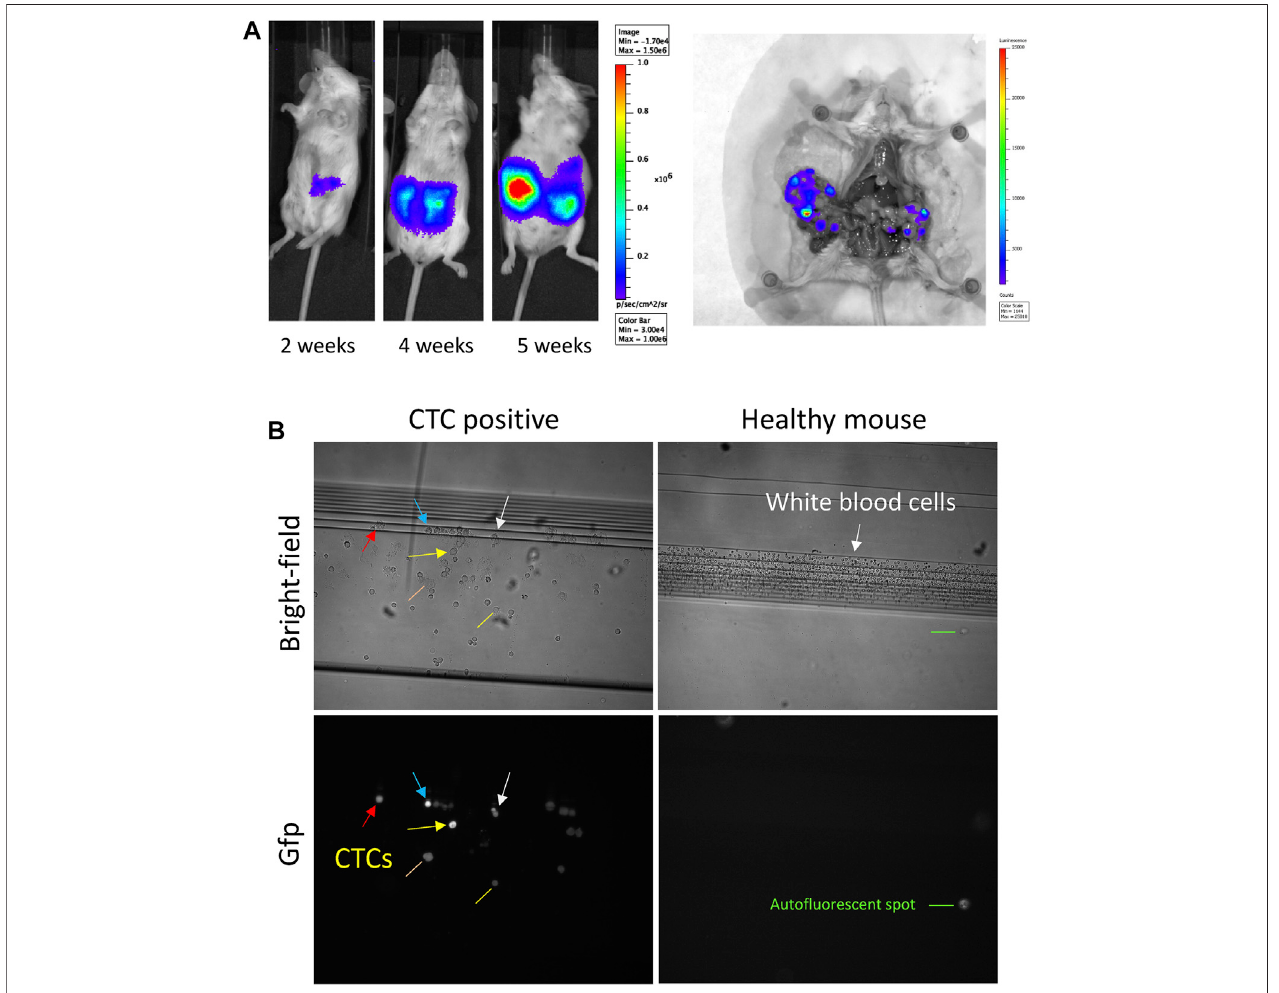
FIGURE 3 | CT26-Luc-Gfp allograft growth in Balb/c mice. (A) In vivo and ex vivo bioluminescence imaging at the indicated times and at sacri fi ce. (B) Bright- fi eld (upperpanels)andGfp fl uorescence(lowerpanels)microscopyofthecellsretainedintheParsortixsystemcassette,fromaCTC-positiveandahealthymouse.Arrowsof the same color indicate the same cell in the upper and lower panel. Yellow and orange lines indicate cells with lower fl uorescence intensity, possibly necrotic. Notice the absence of GFP fl uorescence in the healthy mouse cassette, although numerous cells can be seen in bright fi eld. Green line indicates auto fl uorescence spot. Although in the image it might appear similar to a cell, it is fl uorescent in all channels, thus it can be easily